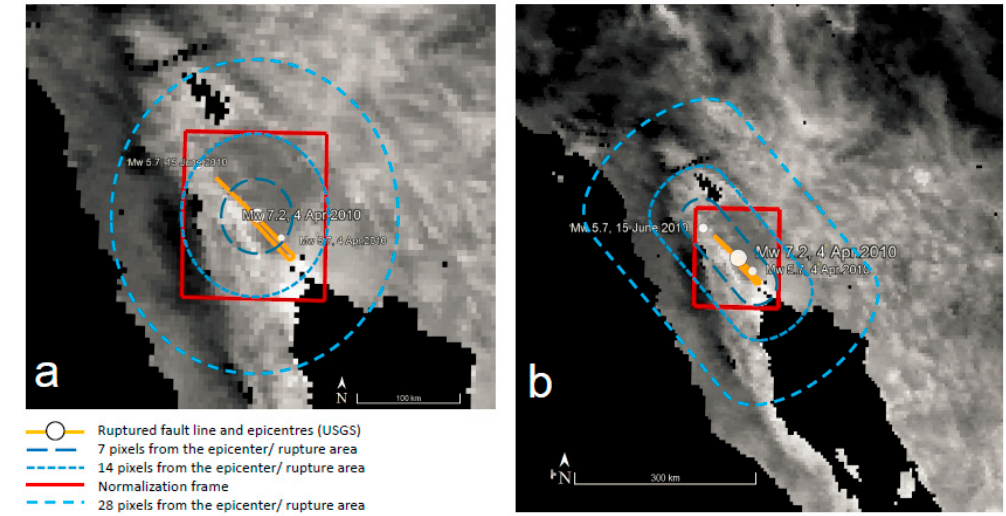
Figure 2. Definition of distance zones in the case of Baja California, Mexico. The images show the Copernicus LST image of 4 April 2010, 09:00 h (day of the earthquake). Without adjustment of the co-seismic period, earthquakes which occur more than 24 h apart are considered separate events. ( a ) Definition of distance zones based only on the earthquake of April 4th. The distance zones (dashed lines) are defined around the epicenter. ( b ) Definition of distance zones based on the whole earthquake sequence (in the case of California, one day before the 4 April event until one day after the 15 June event). Distance zones are defined with regard to the ruptured area, which includes the ruptured fault and the epicenters of all large earthquakes in the sequence. The size of the normalization frame is shown with squares in both panels.